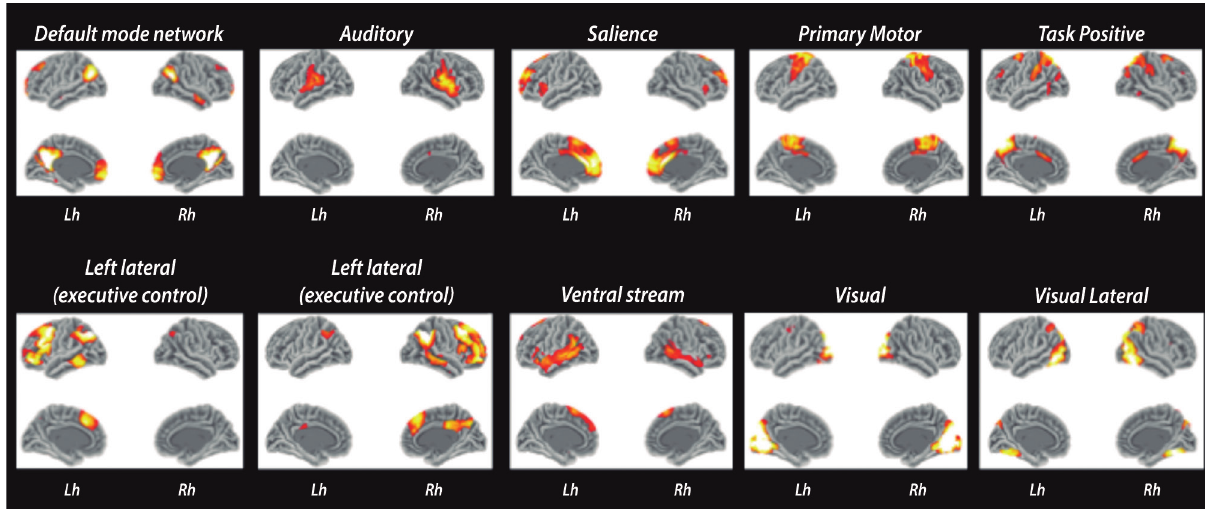
Figure 2. Resting-state fMRI networks. The ten main components of resting-state networks. Images were obtained after processing functional images of 30 healthy controls using FSL toolbox.